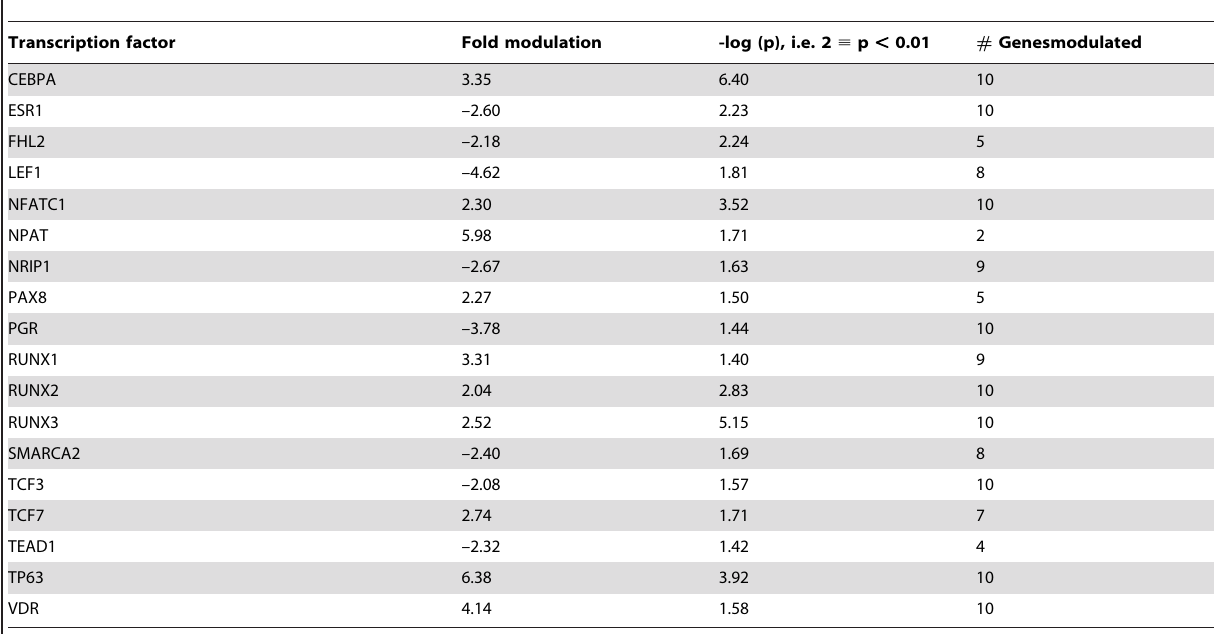
Table 3. Transcription factors identified by Ingenuity Pathway Analysis as modulated by endometrial C. trachomatis infection (determined by downstream target pools).